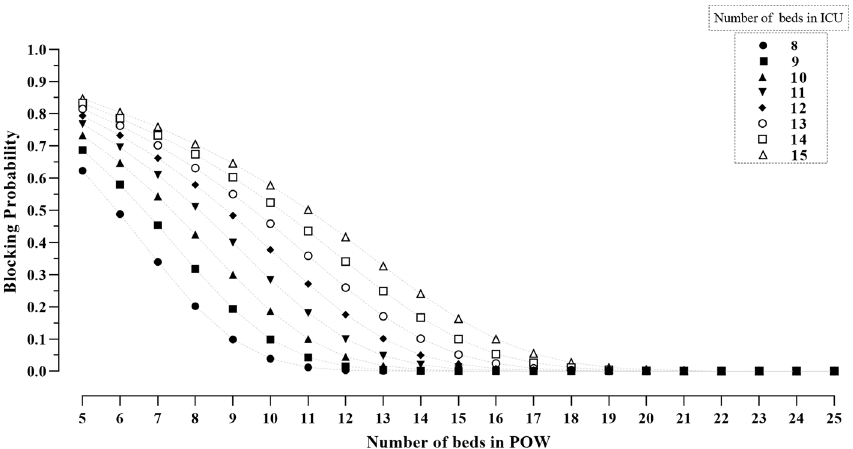
Figure 4. The bed blocking probability (BBP) at post operative ward (POW) for different number of beds in ICU and POW.